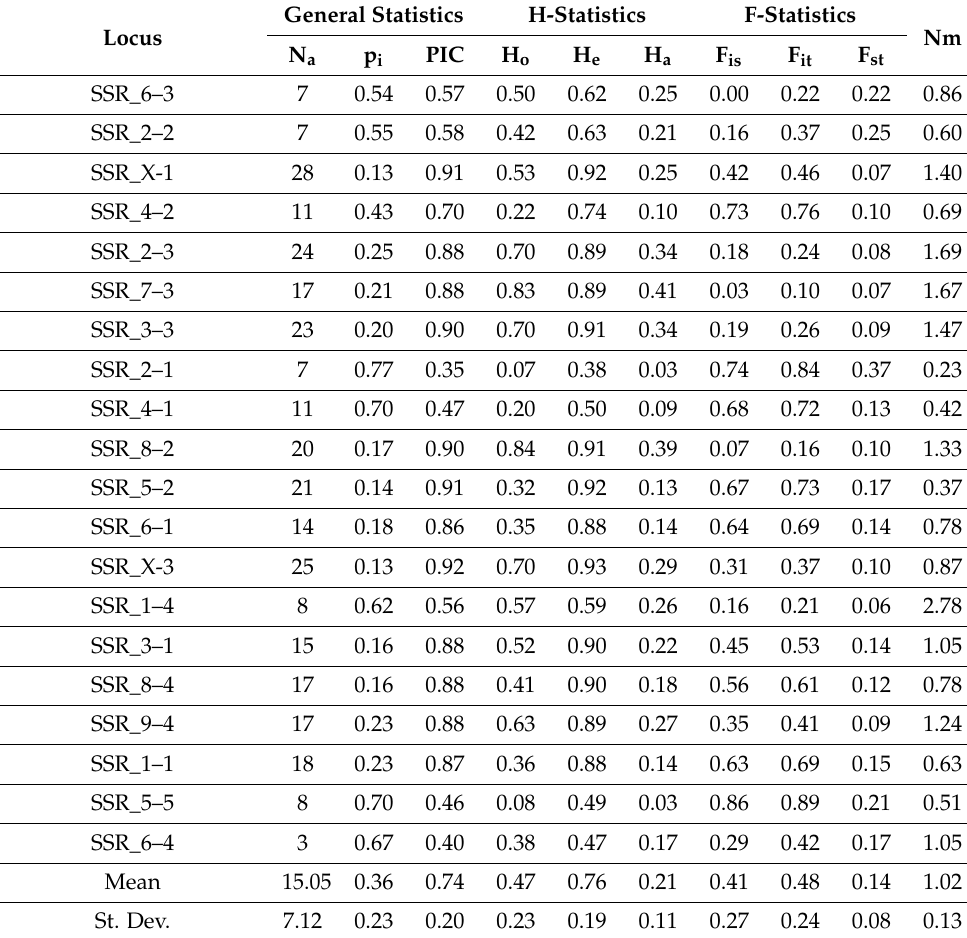
Table 1. Global genetic diversity statistics sorted by locus related to 104 Cannabis individuals based on 20 SSR marker loci. General Locus